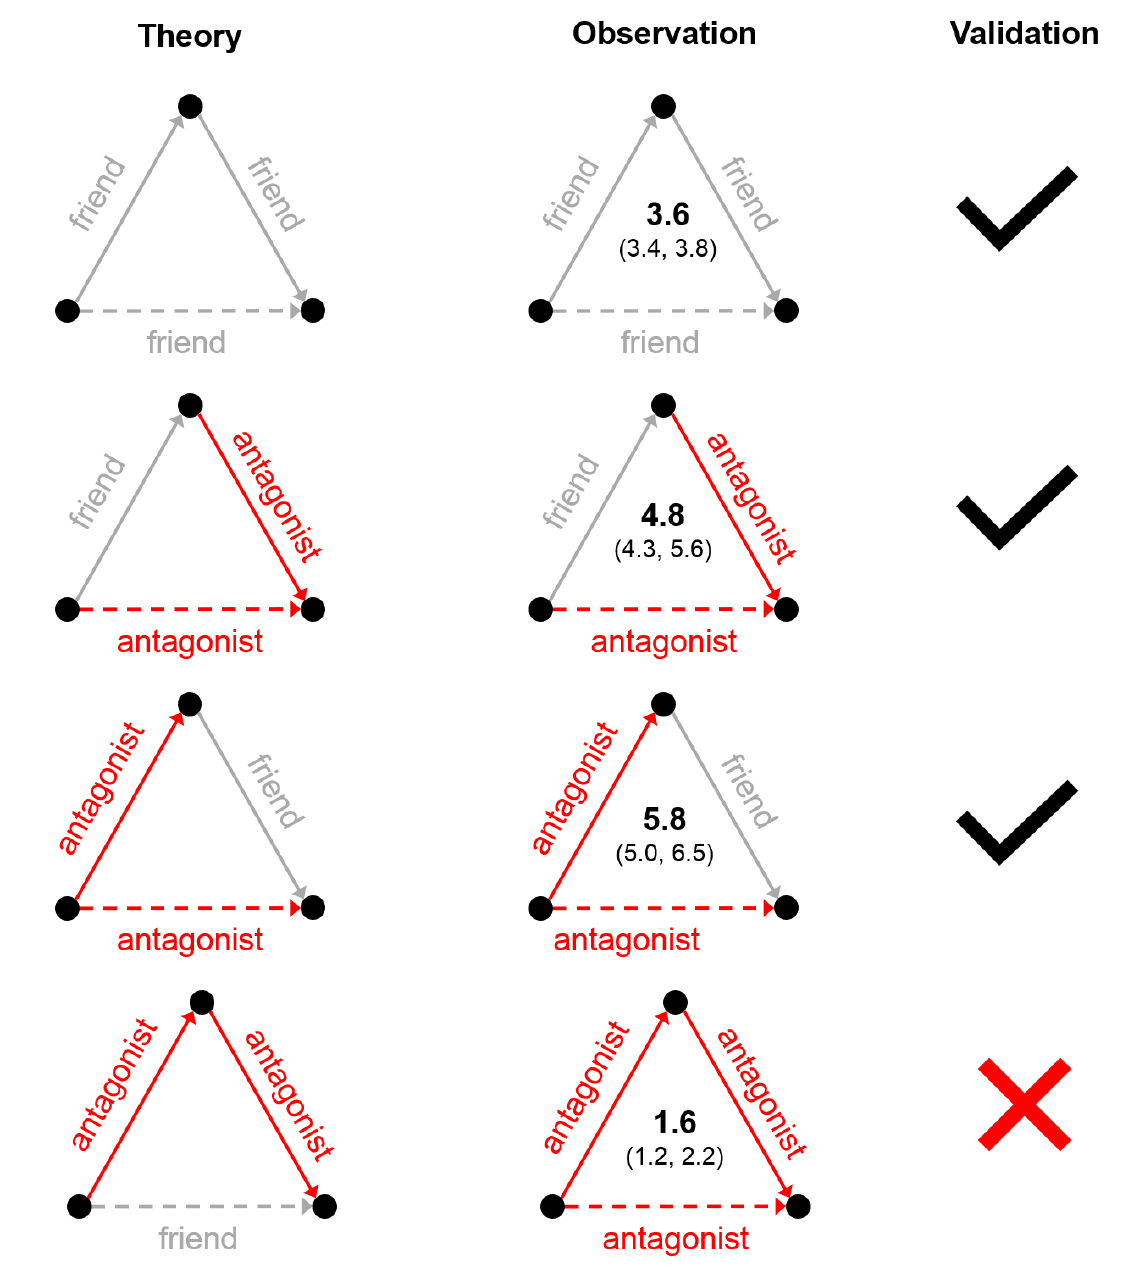
Figure 1: Experimental observations of balance theory. The first column shows the expected balanced triads from traditional balance theory. In the top triangle, we expect the friend of your friend to be your friend (dashed gray line). In the next two triangles, we expect the antagonist of your friend and the friend of your antagonist to be your antagonist (dashed red line). Finally, balance theory predicts that the antagonist of your antagonist is expected to be your friend (dashed gray line) rather than your antagonist. The second column shows results in a large data set of 105,175 positive and 16,448 negative ties. The inset numbers indicate the relative probability of the observed tie compared to chance. The smaller numbers represent the 99.5 percent confidence interval. Column 3 shows that we validate the first three rules of balance theory but that the fourth rule is not empirically confirmed. Rather, in reality, “the enemy of my enemy is my enemy.” sociological science |